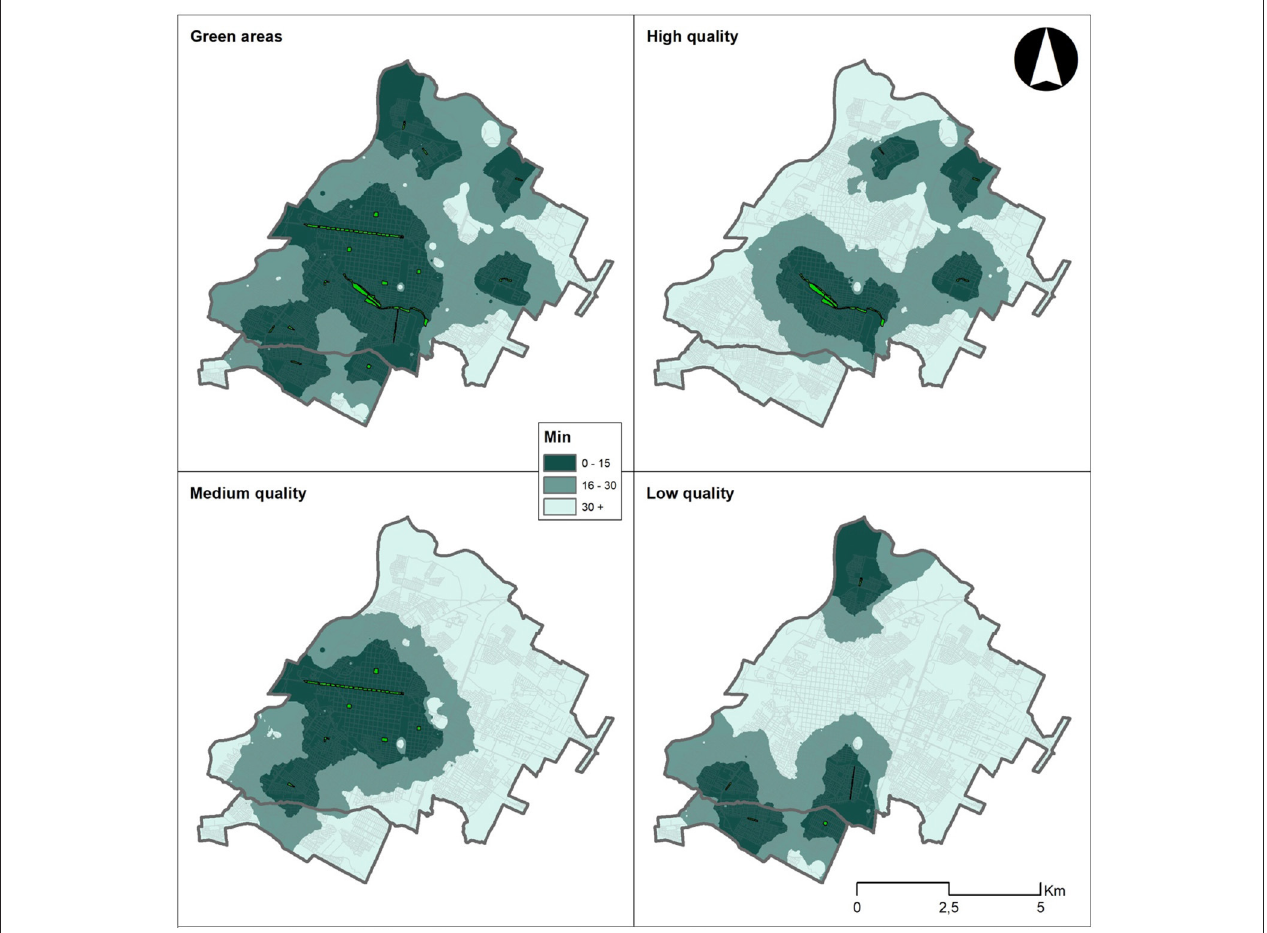
FIGURE 11 | Accessibility of green spaces in Talca, with green space quality levels obtained from the